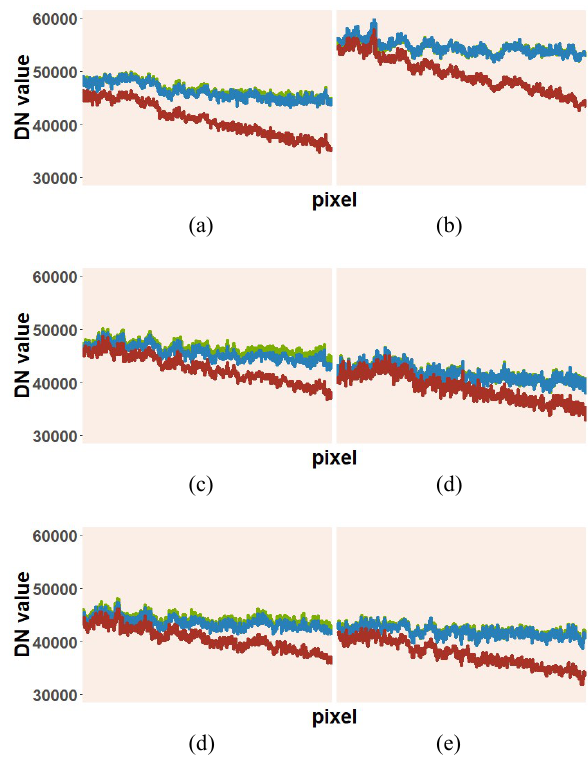
Figure 3. DNs extracted along profile from raw image (red lines), laboratory corrected image (blue lines) and in-situ corrected image (green lines): ( a ) Band 1; ( b ) Band 2; ( c ) Band 3; ( d ) Band 4; ( e ) Band 5; ( f ) Band 6.